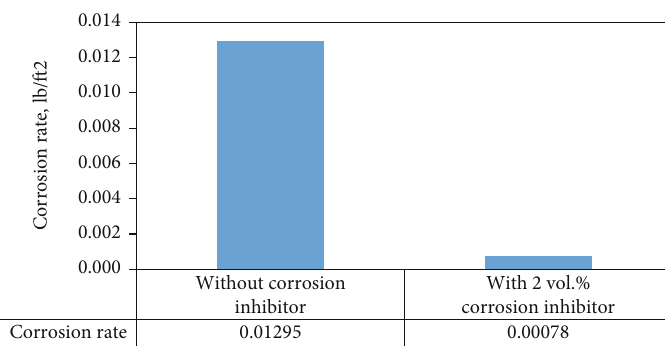
Figure 9: Corrosion rate at 100 ° C with and without the corrosion